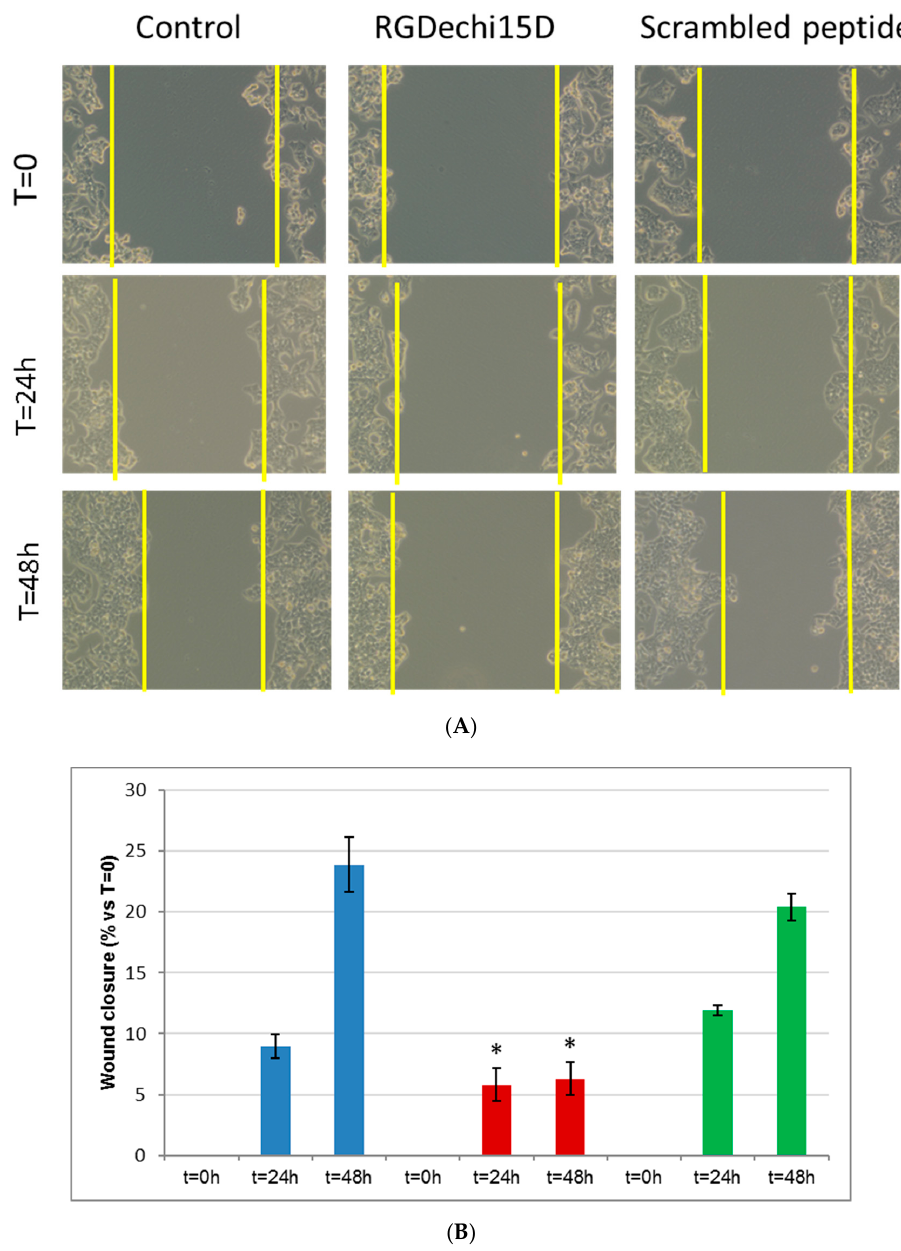
Figure 4. E ff ect of RGDechi15D on wound healing activity. ( A ) The wound closure was determined by the scratch assay. After the treatment, the cells were photographed using phase-contrast microscopy at 0, 24, and 48 h. ( B ) Quantification of wound closure. Graphic represents the wound width for each treatment, expressed as the mean ± SE of the percentage of the wound width at 24 or 48 h with respect to t = 0. The means resulted from at least three independent experiments performed in triplicate. Statistical significance was analyzed using Student’s t test, unpaired, two-sided (* p < 0.05). Blue: control; Red: RGDechi15D; Green: scrambled